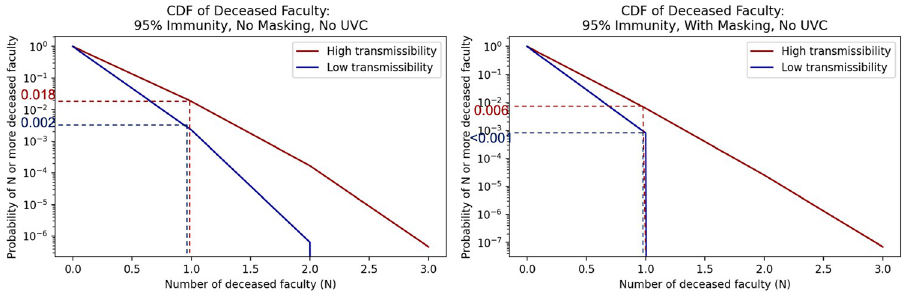
Fig 9. Inverse cumulative density functions for the total number of faculty that die under the different scenarios. Each graph shows the curve of the probability of exceeding a given number of deaths.